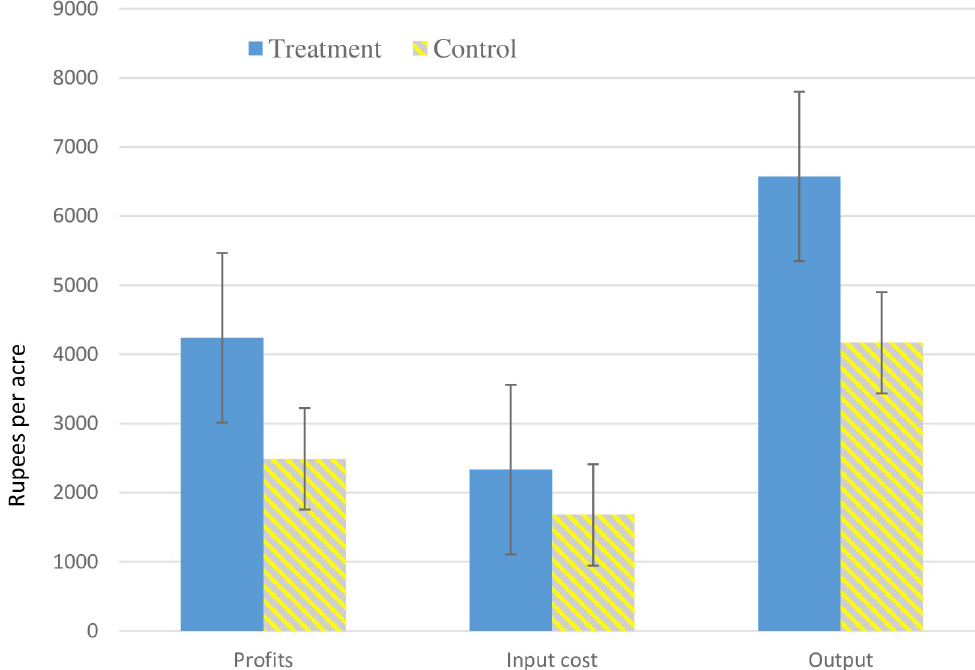
Fig 3. Profits, input cost, and output for the mean pigeon pea farmer. Notes: Input costs are in Indian rupees per acre that include the cost of ploughing, harrowing, sowing, transplanting, interculture operations, weeding, micronutrients, insecticide, manure, fertilizer, threshing, and winnowing. The input costs for the mean treatment farmer is 39% higher compared to the mean control farmer. The output per acre is 58% higher for the mean treatment farmer relative to the mean control farmer. Profits in Indian rupees per acre are the output net of input costs per acre. Profits for the mean treatment farmer was 70% higher compared to the mean control farmer.